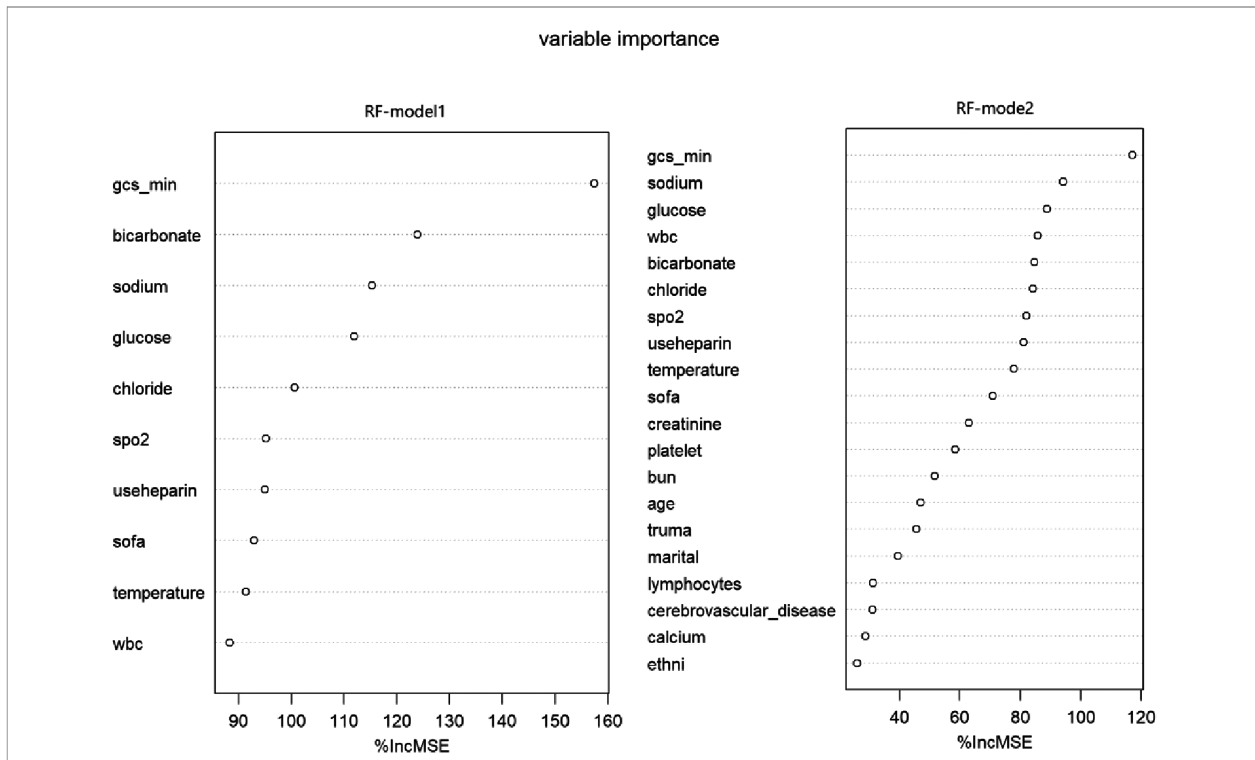
FIGURE 7 | Variable importance in RF models. RF, random forest; Model1 was adjusted for GCS, glucose, sodium, chloride, SPO 2 , bicarbonate, temperature, white blood cell (WBC), heparin use, and SOFA score. Model2 was adjusted for GCS, glucose, sodium, chloride, SPO 2 , bicarbonate, temperature, white blood cell (WBC), heparin use, SOFA score, creatinine, bun, platelet, age, marital, trauma, lymphocytes, calcium, race, and cerebrovascular